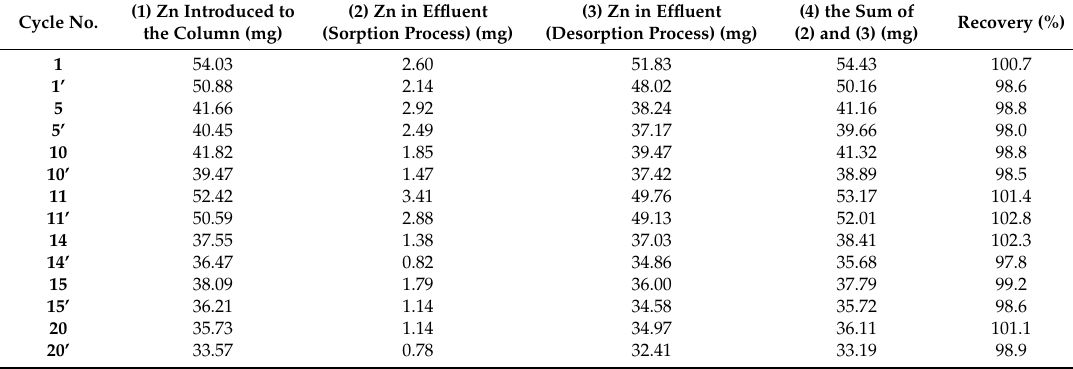
Table 2. The mass balance of repeated zinc(II) ions sorption–desorption cycles in column studies. Cycle